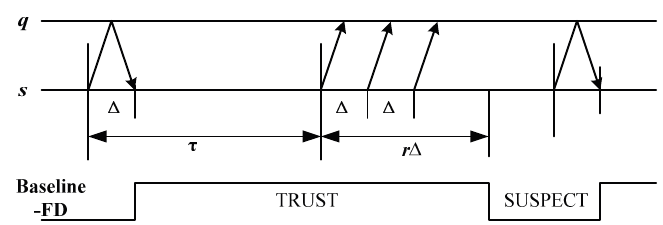
Figure 1. Baseline detection